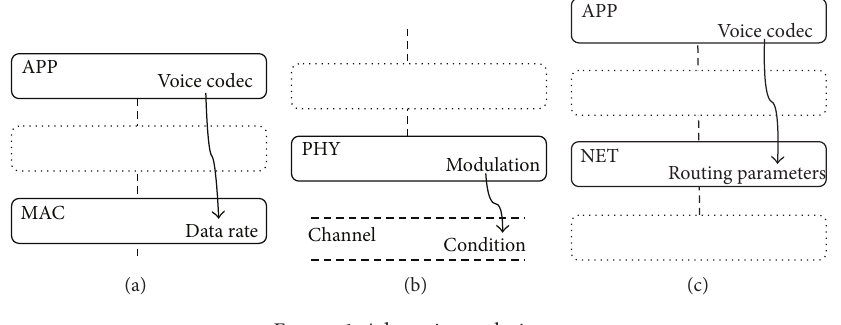
Figure 1: Adaptation